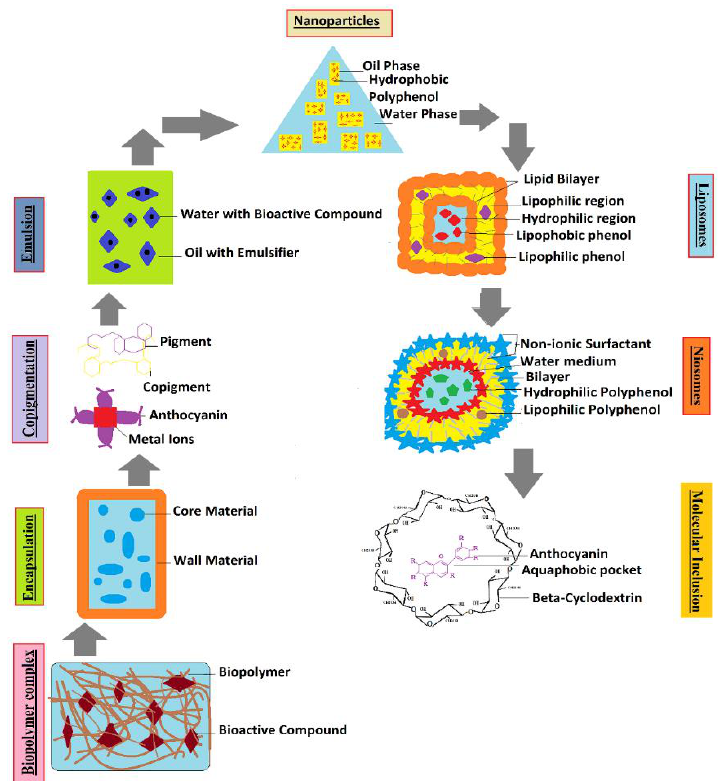
Figure 4. Formulation of different conventional and advanced delivery systems used for encapsulation of ACN pigments in different biopolymer complexes (carbohydrates, protein, lipids), and wall materials.